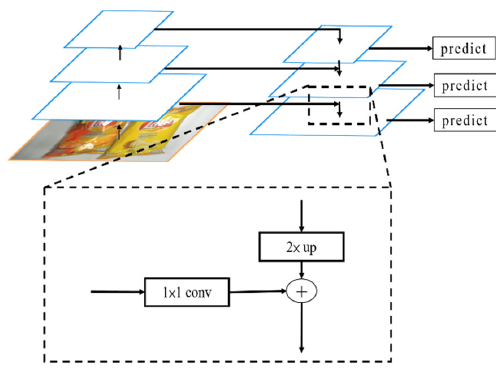
Table 3. Comparison of error rates for nine models.